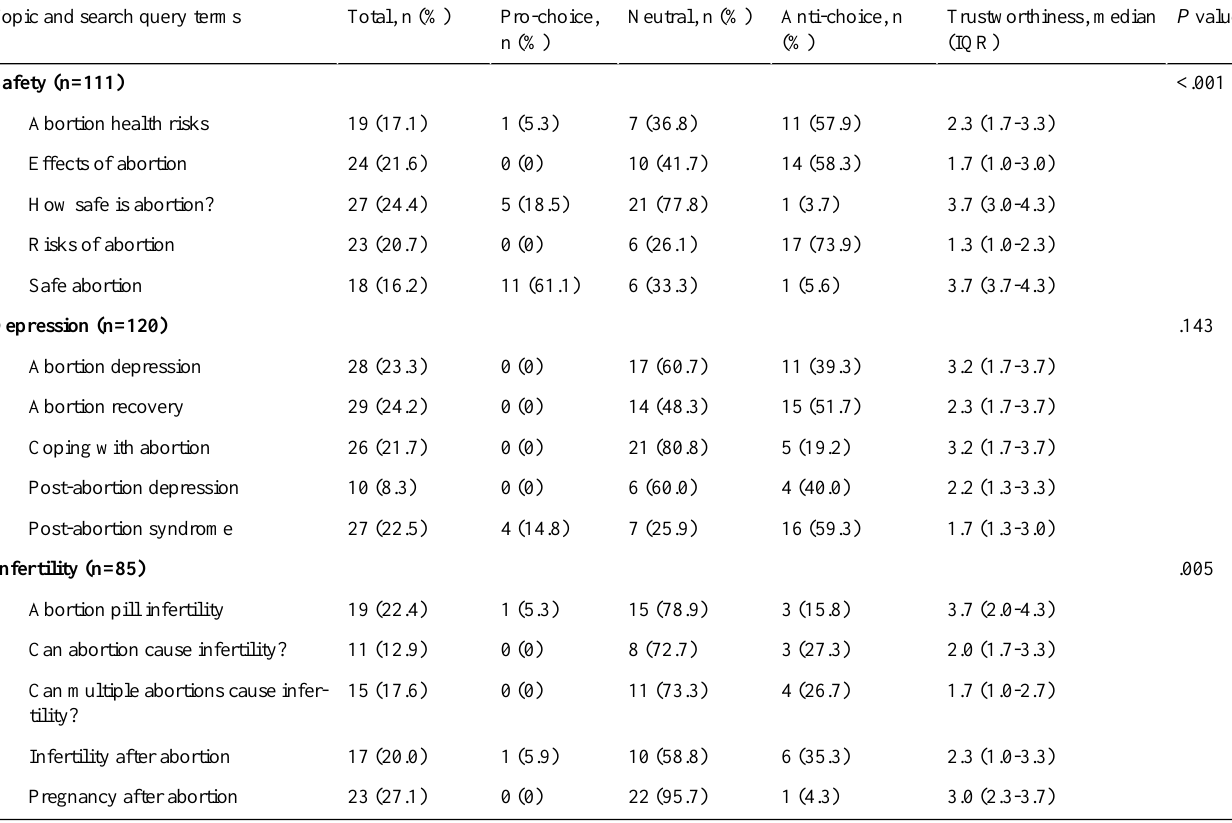
Table 2. Search query terms used and associated trustworthiness and website slant for each search topic.